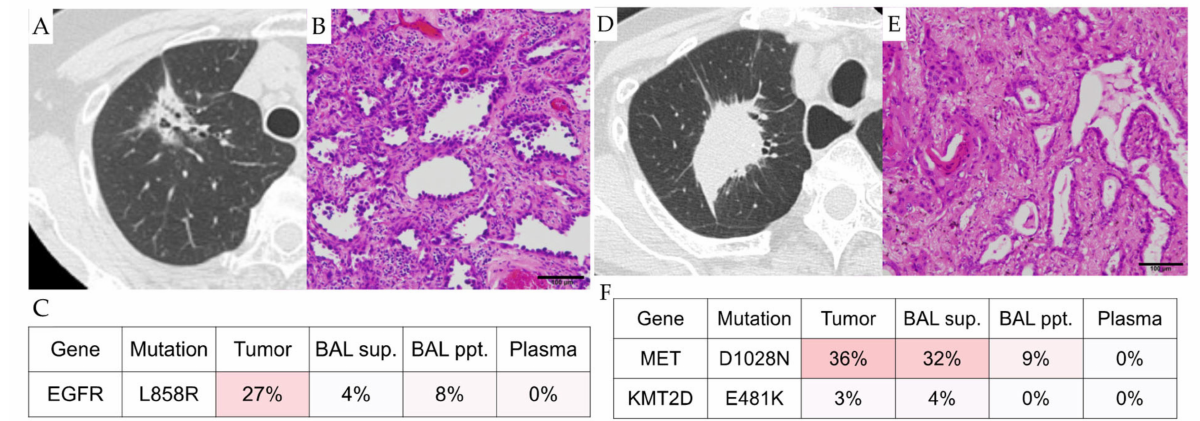
Figure 2. Representative Cases. ( A – C ): Case 1. ( A ), CT image; ( B ), histology; ( C ), heatmap of mutations detected in the samples. ( D – F ): Case 2. ( D ), CT image; ( E ), histology; ( F ), heatmap of mutations detected in the samples. The scale bars indicate 100 µ